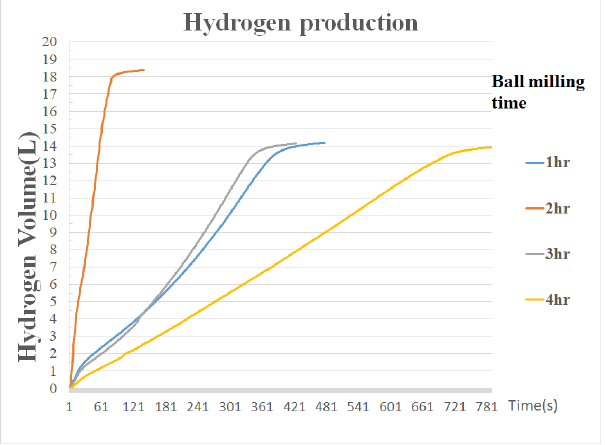
Figure 6. Comparison of hydrogen production rates of different ball milling times.